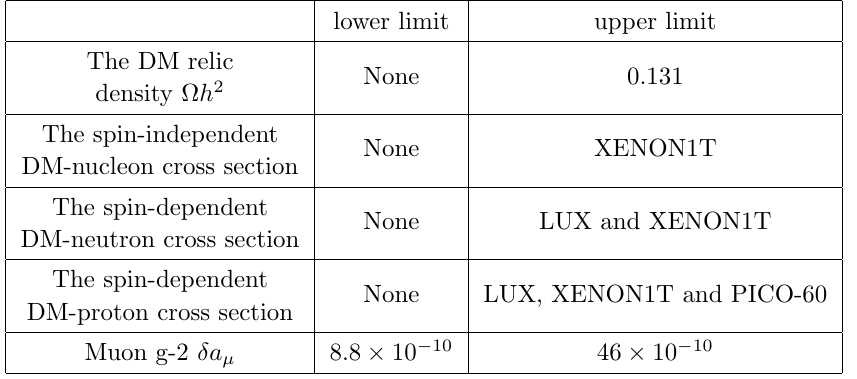
Table 2 . The upper and lower bounds of the dark matter and muon g-2